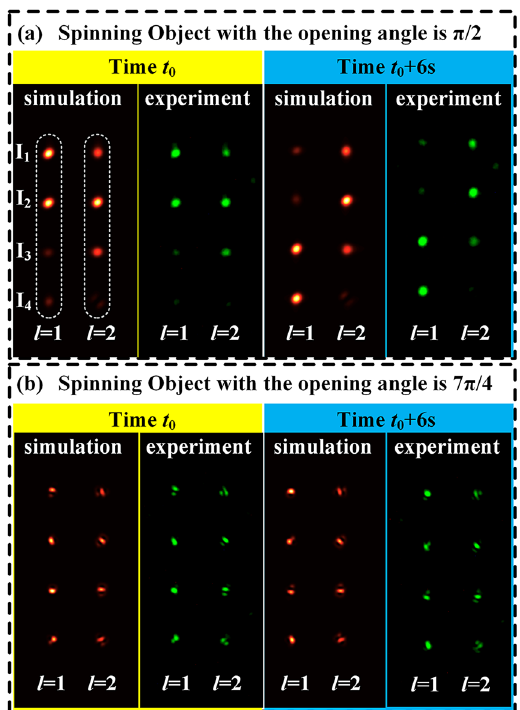
Figure 4: Two-dimensional phase-to-intensity measurement array. (a) Simulation and experimental results of the object with opening angle is π /2 measured at t 0 , and t 0 + 6 s. (b) Simulation and experimentalresultsoftheobjectwithopeningangleis7 π /4measured at t 0 , and t 0 + 6 s. The angular velocity of both objects was π /6 rad/s (counterclockwise rotation). The relative phase of the OAM state could be calculated in real-time by the energy of four foci I 1 , I 2 , I 3 , I 4